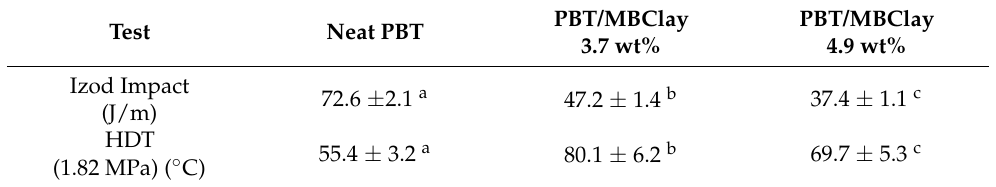
Table 6. Izod impact and HDT test results for the neat PBT and PBT/MBClay